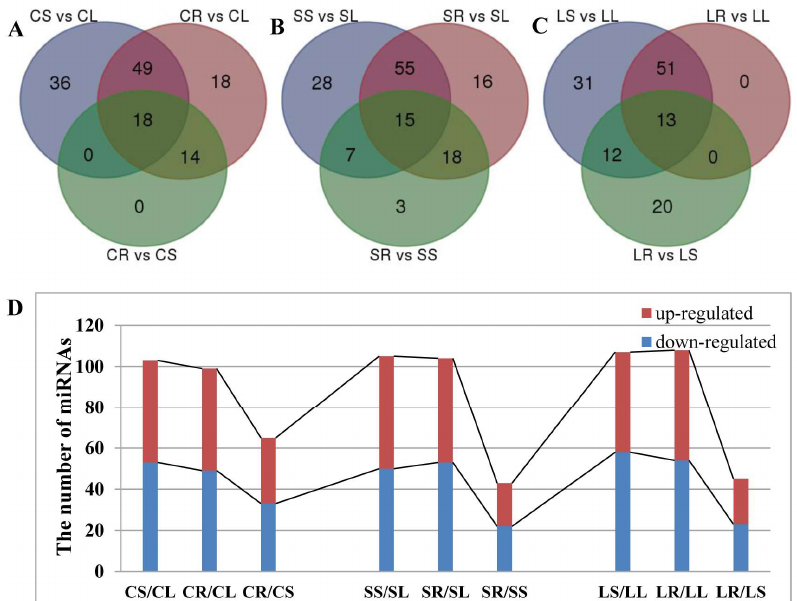
Figure 3. Significant differentially expressed miRNAs across the leaves, roots and stems in P. euphratica . ( A ) Venn diagram of significant differentially expressed miRNAs in the control groups of leaves, roots and stems. ( B ) Venn diagram of significant differentially expressed miRNAs in the one-day-treatment groups of leaves, roots, and stems. ( C ) Venn diagram of significant differentially expressed miRNAs in the four-day treatment groups of leaves, roots and stems. ( D ) The number of up- or downregulated miRNAs between each comparison in the different tissues.